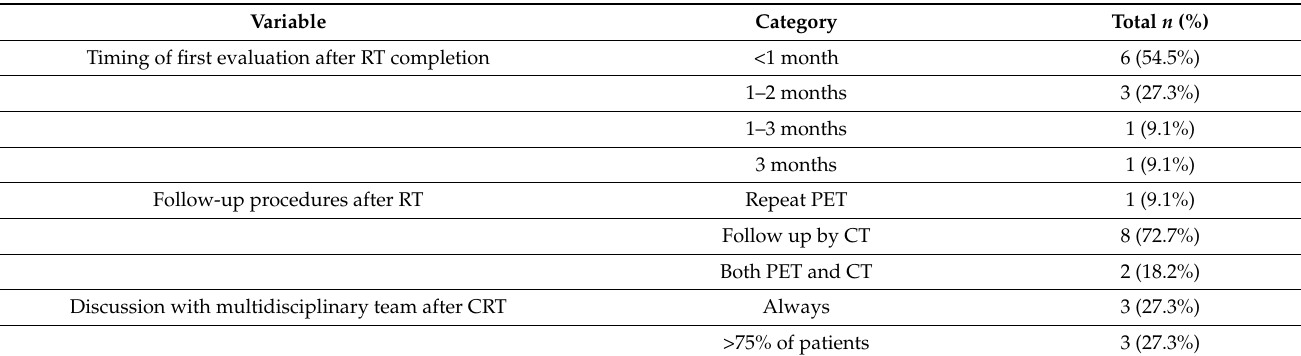
Table 3. Current practices for stage III NSCLC treatment on post chemoradiation